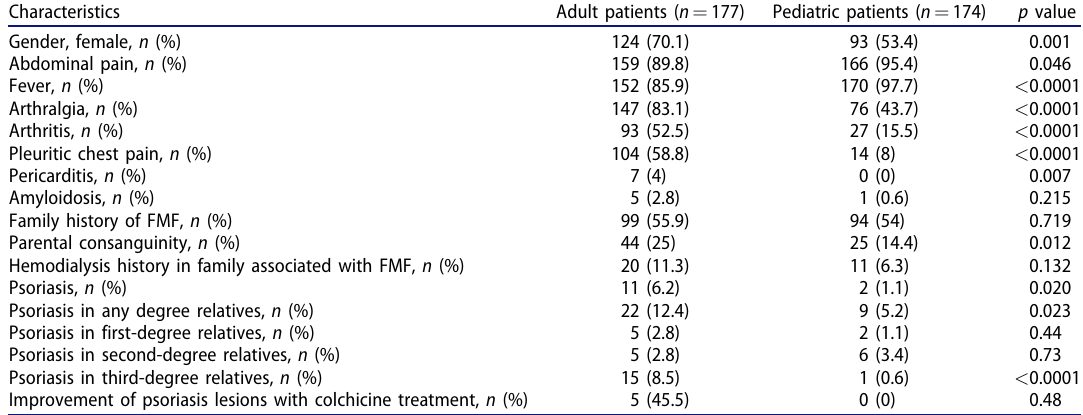
Table 1. Demographic and clinical characteristics of 177 adult and 174 pediatric patients with familial Mediterranean fever (FMF).